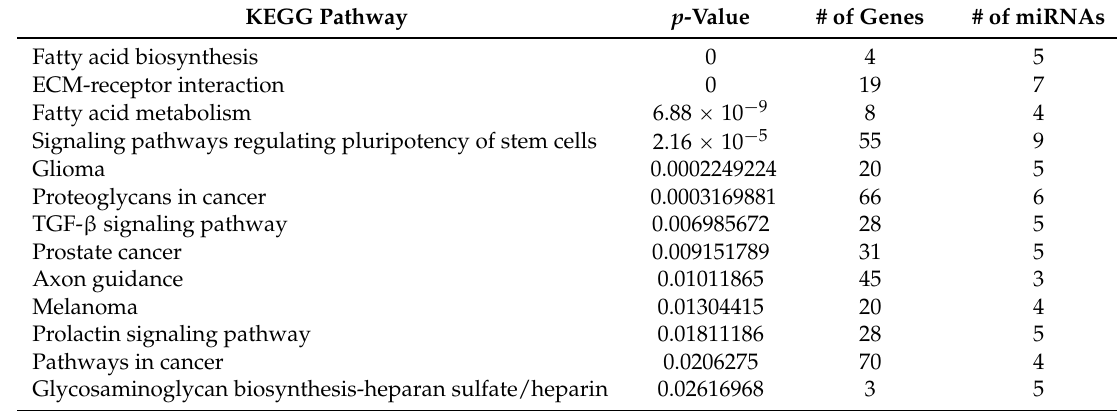
Table 5. Enriched KEGG pathways for predicted targets of the DDR microRNAs modulated by CRC. KEGG Pathway p -Value # of Genes Fatty acid biosynthesis